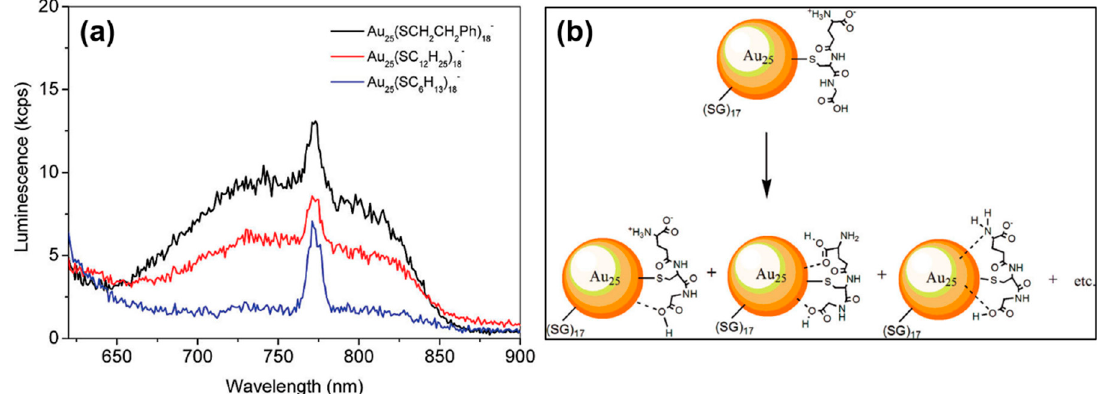
Figure 6. ( a ) Weak fluorescence of [Au 25 (SR) 18 ]- with different R groups (–C 2 H 4 Ph, –C 12 H 25 , and –C 6 H 13 ). ( b ) Possible Interactions of amine and carboxyl groups of glutathione (–SG) ligands to the gold surface. Reprinted with permission from Ref. [33]. Copyright (2010) American Chemical